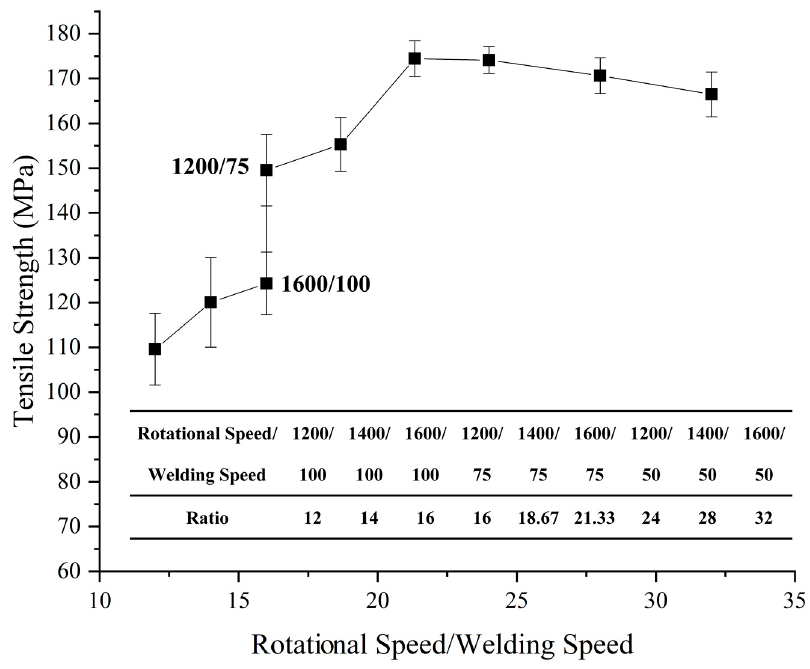
Figure 6. Relationship between welding line energy and mechanical properties.